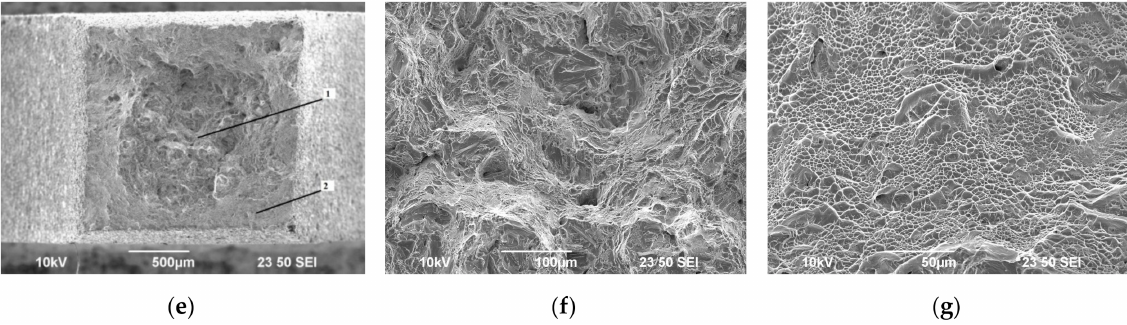
Figure 6. General view of the specimens after tension tests ( a ) and the fractographic analysis of the fractures of the Ti ( b – d ) and Ti5Al2V alloy ( e – g ), ( b , e )—general view of fractures, zones of arising and propagation of the cracks and the failure zones are marked as “1” and “2”, respectively, ( c , f )—regions of arising and propagation of the cracks, ( d , g )—failure zones (SEM).